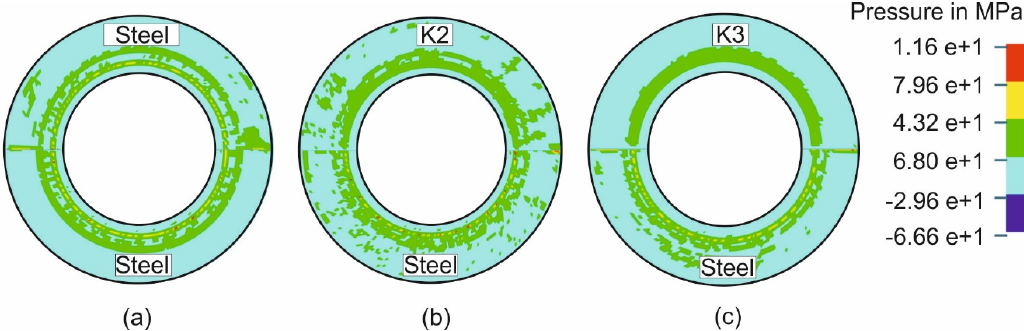
Figure 5. Pressure distributions in Setup 1 ( a ) and Setup 3 ( b ) and Setup 4 ( c ).